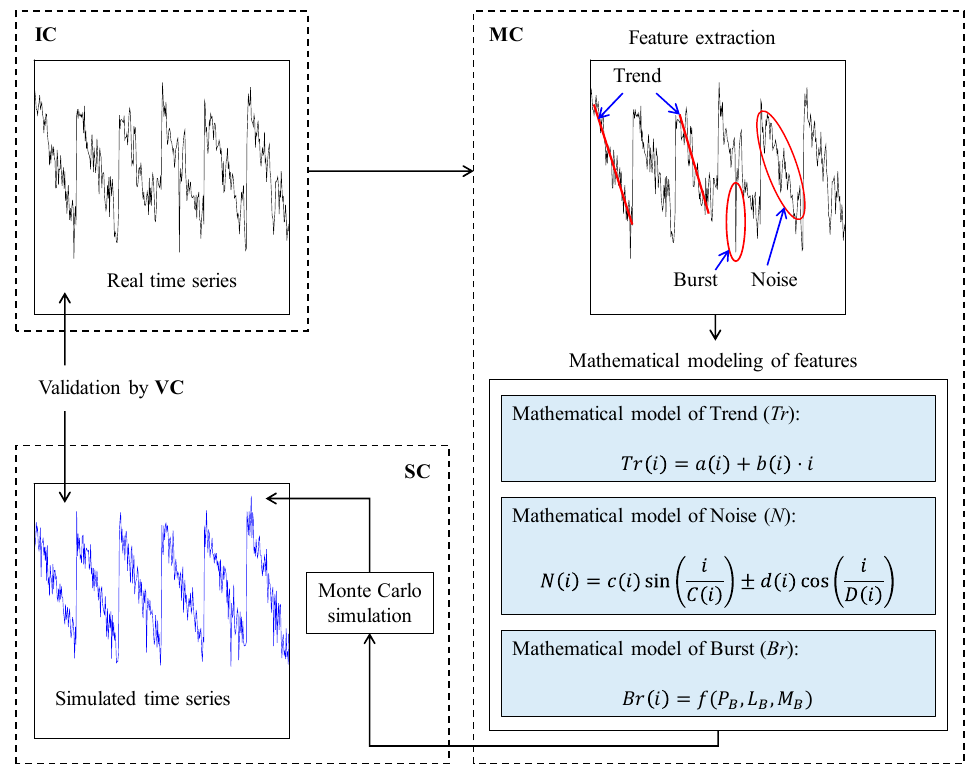
Figure 9. Outlining phenomenon twin construction of surface roughness using the semantic modeling approach [16].